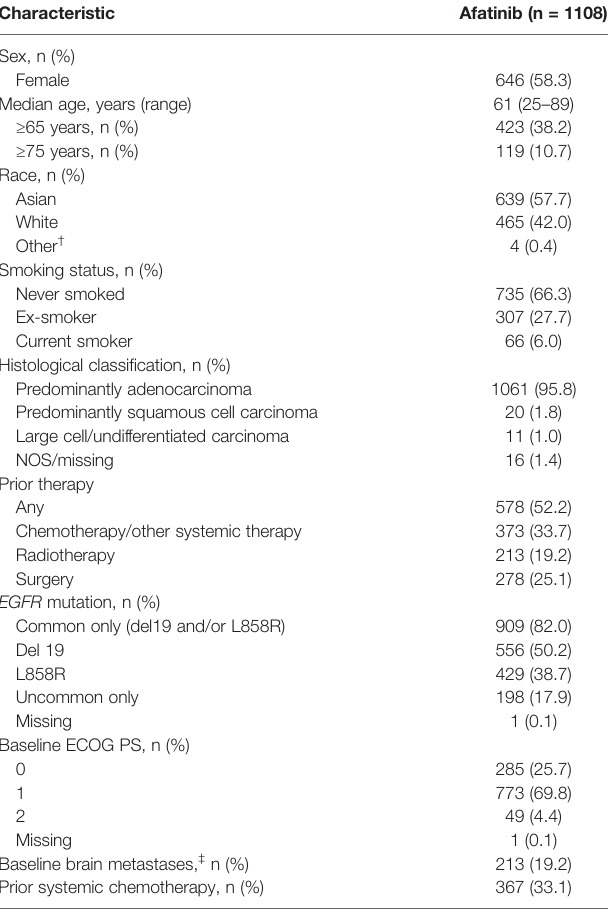
TABLE 1 | Baseline demographics and disease characteristics in the treated